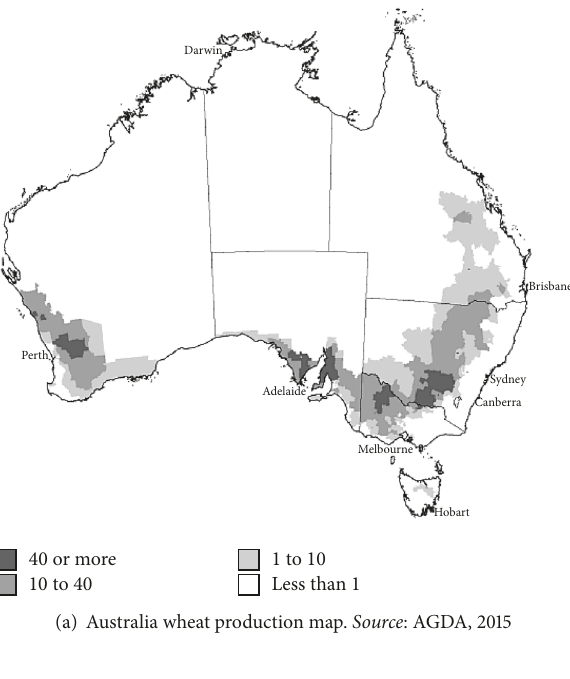
Australia index of precipitation from average